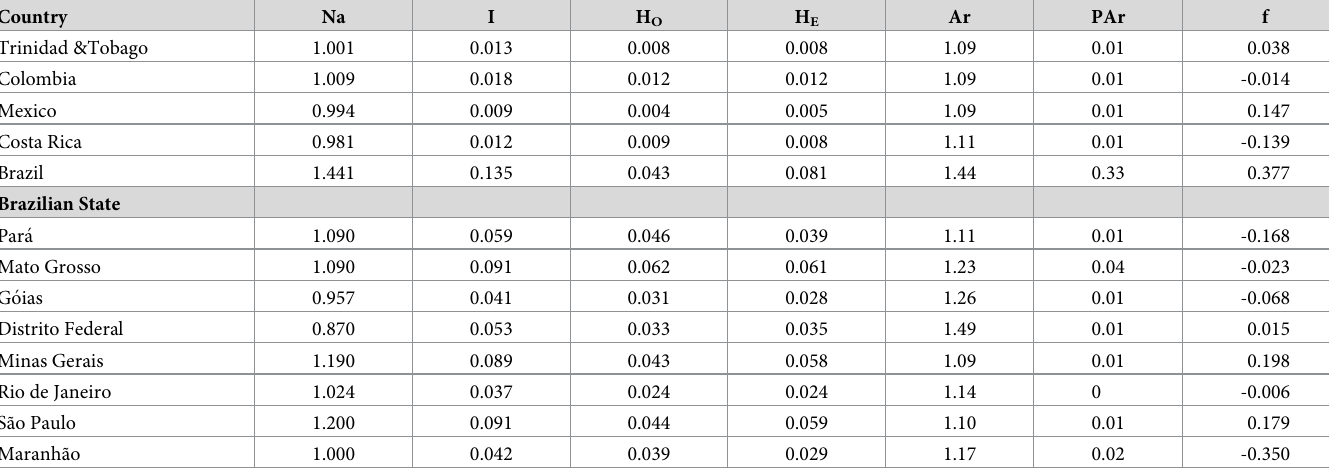
Table 3. Genetic diversity parameter estimates for A . aculeata calculated from 3259 neutral loci of